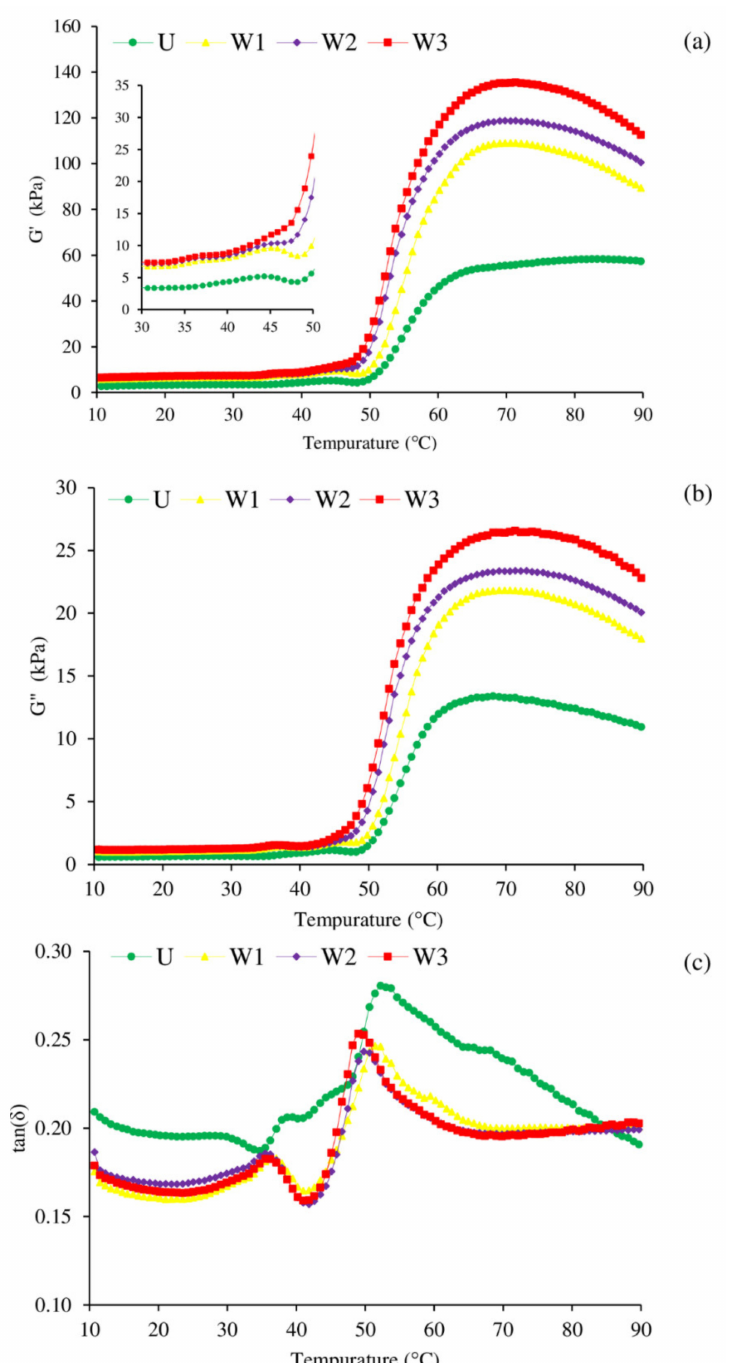
Figure 2. Changes in dynamic viscoelastic behavior of unwashed mince (U) and surimi pastes from Indian mackerel prepared by one washing cycle (W1), two washing cycles (W2), and three washing cycles (W3). The rheograms show elastic modulus, G’ ( a ), viscous modulus, G” ( b ), and tan δ ( c ). Samples were heated from 10 ◦ C to 90 ◦